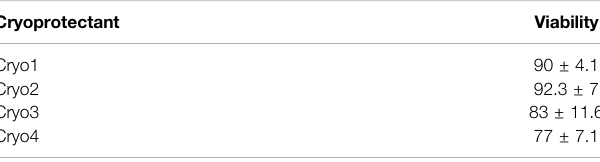
TABLE 3 | Viability of the frozen-thawed (Cryo 1 through Cryo 4) cells after their incubation for 30 min at 37 ° C. Mean values ± SEM are shown. The viability was performed from 5 samples.